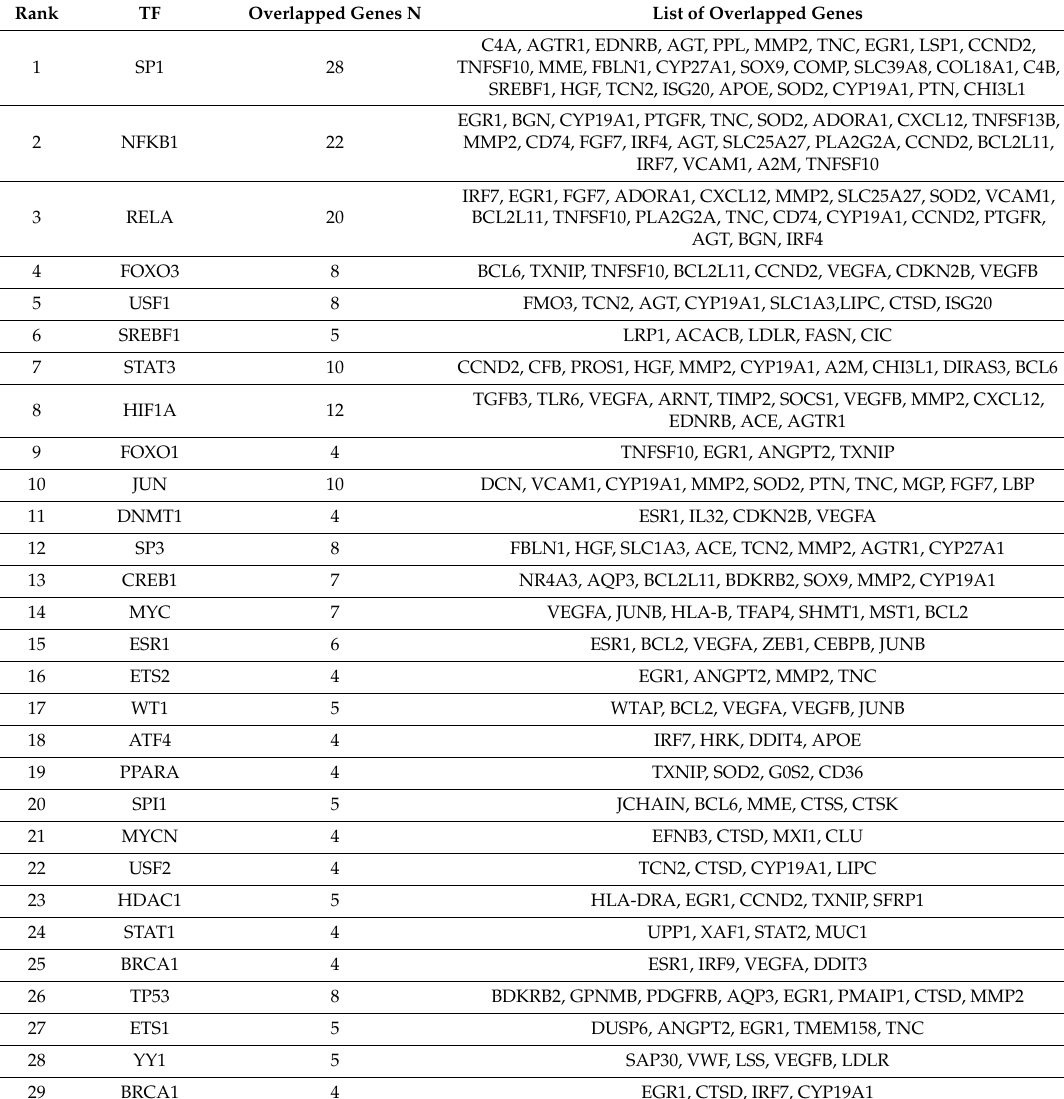
Table 1. Transcription factors with significantly increased activity evaluated by expression of their targets in MSC-based cell sheets compared to monolayer MSC. TF—transcription factor; entries ranked by Q-value and p -value; TFs with 4 and more overlapping targets